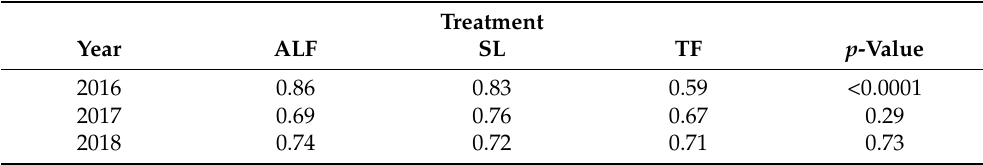
Table 1. Mean steer ADG (kg d − 1 ) over each grazing season (May to September). p -values represent treatment differences for each respective year. ALF = tall fescue interseeded with alfalfa, SL—tall fescue interseeded with lespedeza, and TF—tall fescue control. Treatment ALF